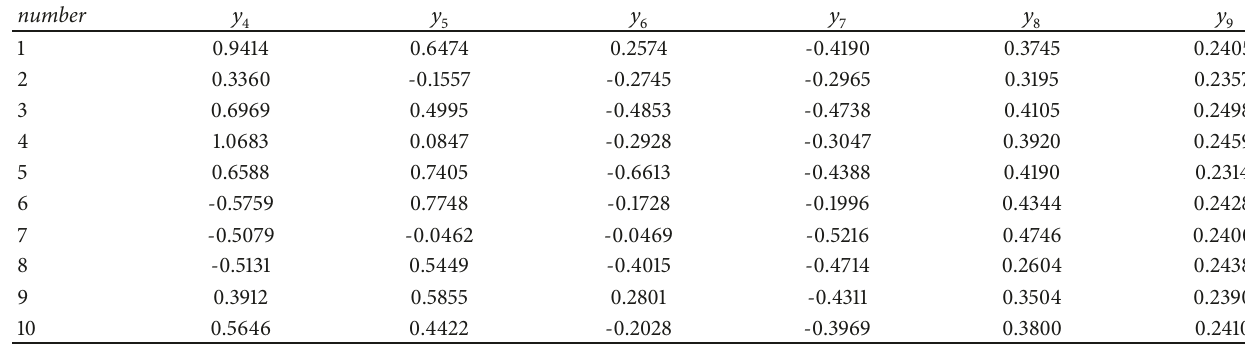
Table 7: The category feature of multiwavelet entropy of the moderate drought stress group.